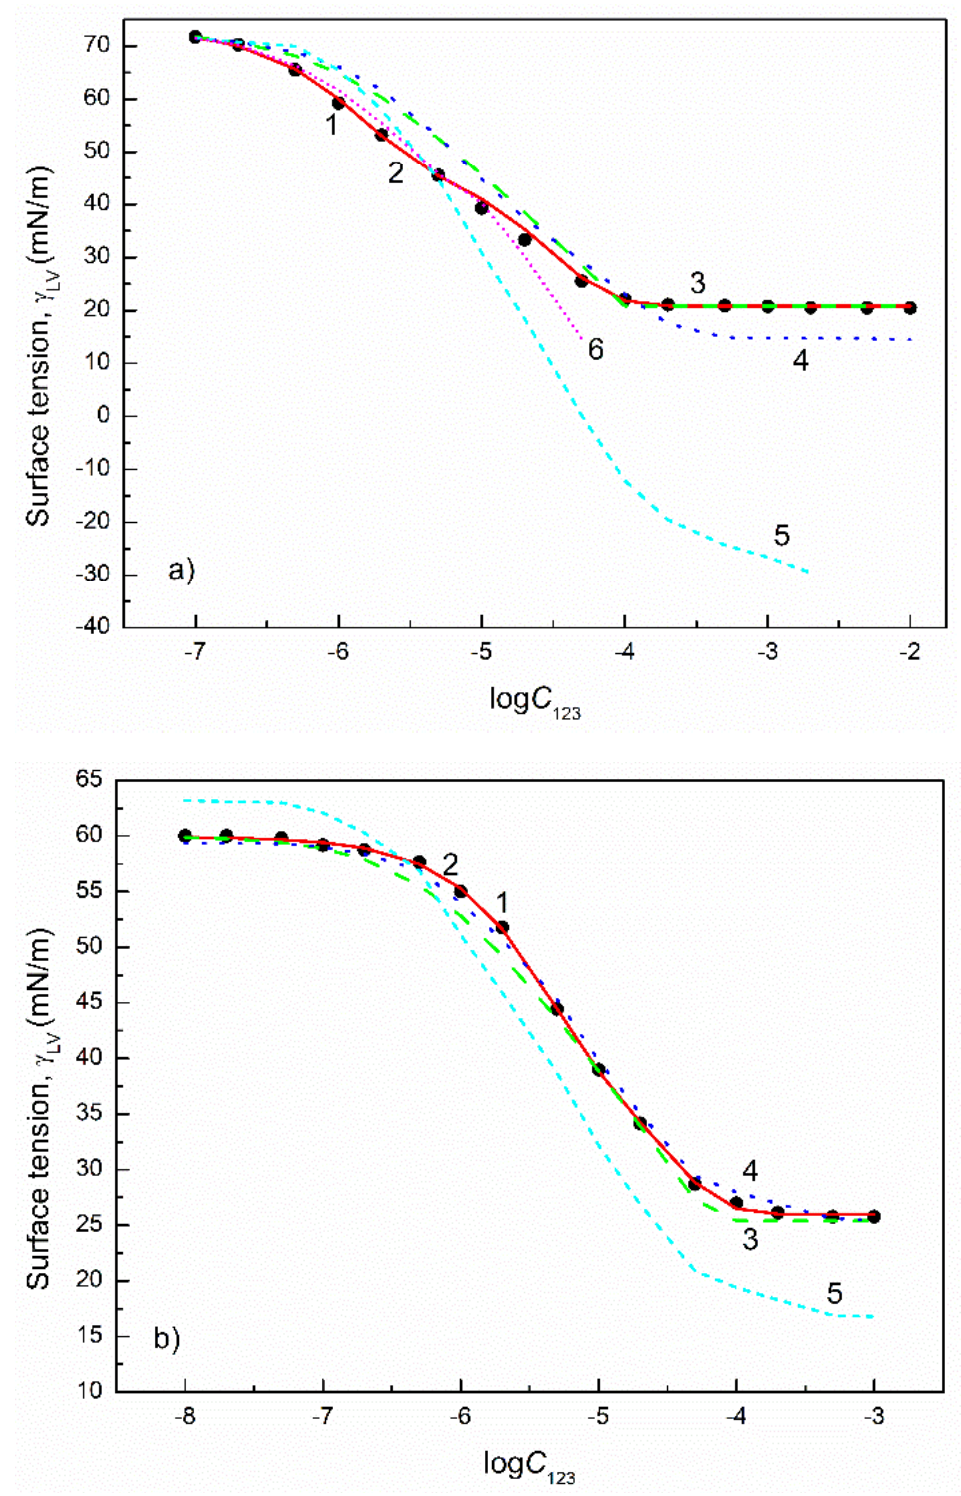
Figure 13. The plot of the surface tension ( γ LV ) of the aqueous solutions of FC1+FC2+SDDS ( a ) and CTAB+TX100+FC1 ( b ) mixtures vs. the logarithm of their concentration ( logC 123 ). Points 1 correspond to the measured values [49], curves 2–6 correspond to the values calculated from the exponential function of the second order (Equation (2)), Szyszkowski equation (Equation (3)), Fainerman and Miller equation (Equation (11)), independent adsorption (Equation (15)) and Joos equation (Equation (13)), respectively.